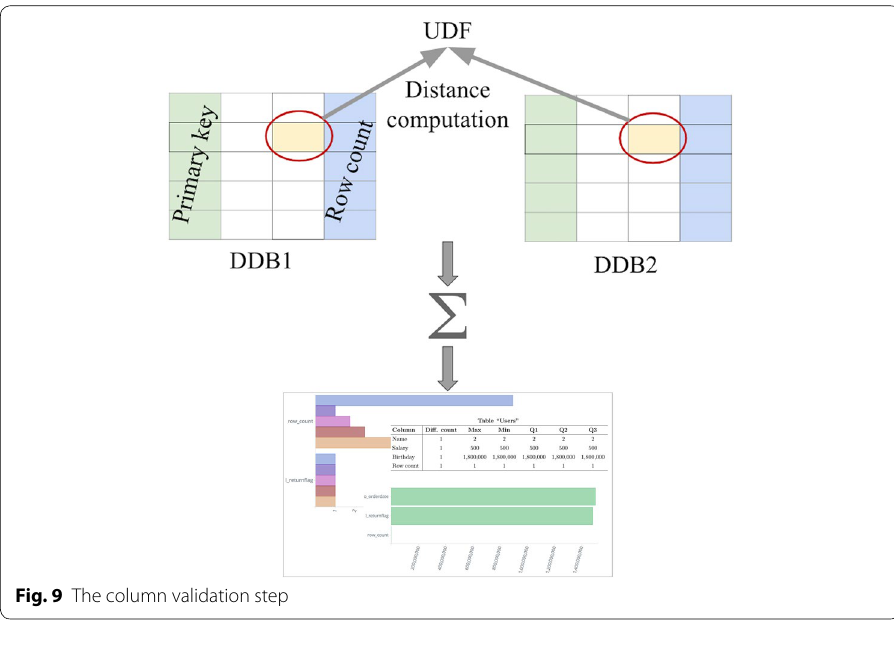
Fig. 9 The column validation